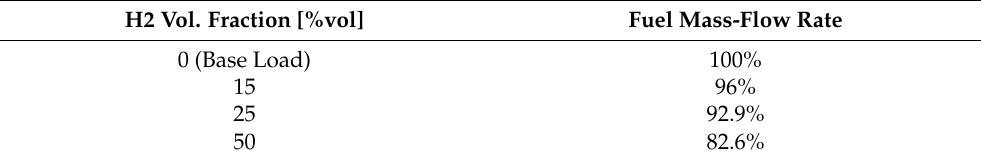
Table 3. Normalized fuel mass-flow rates for CNG and the different HCNG blends.